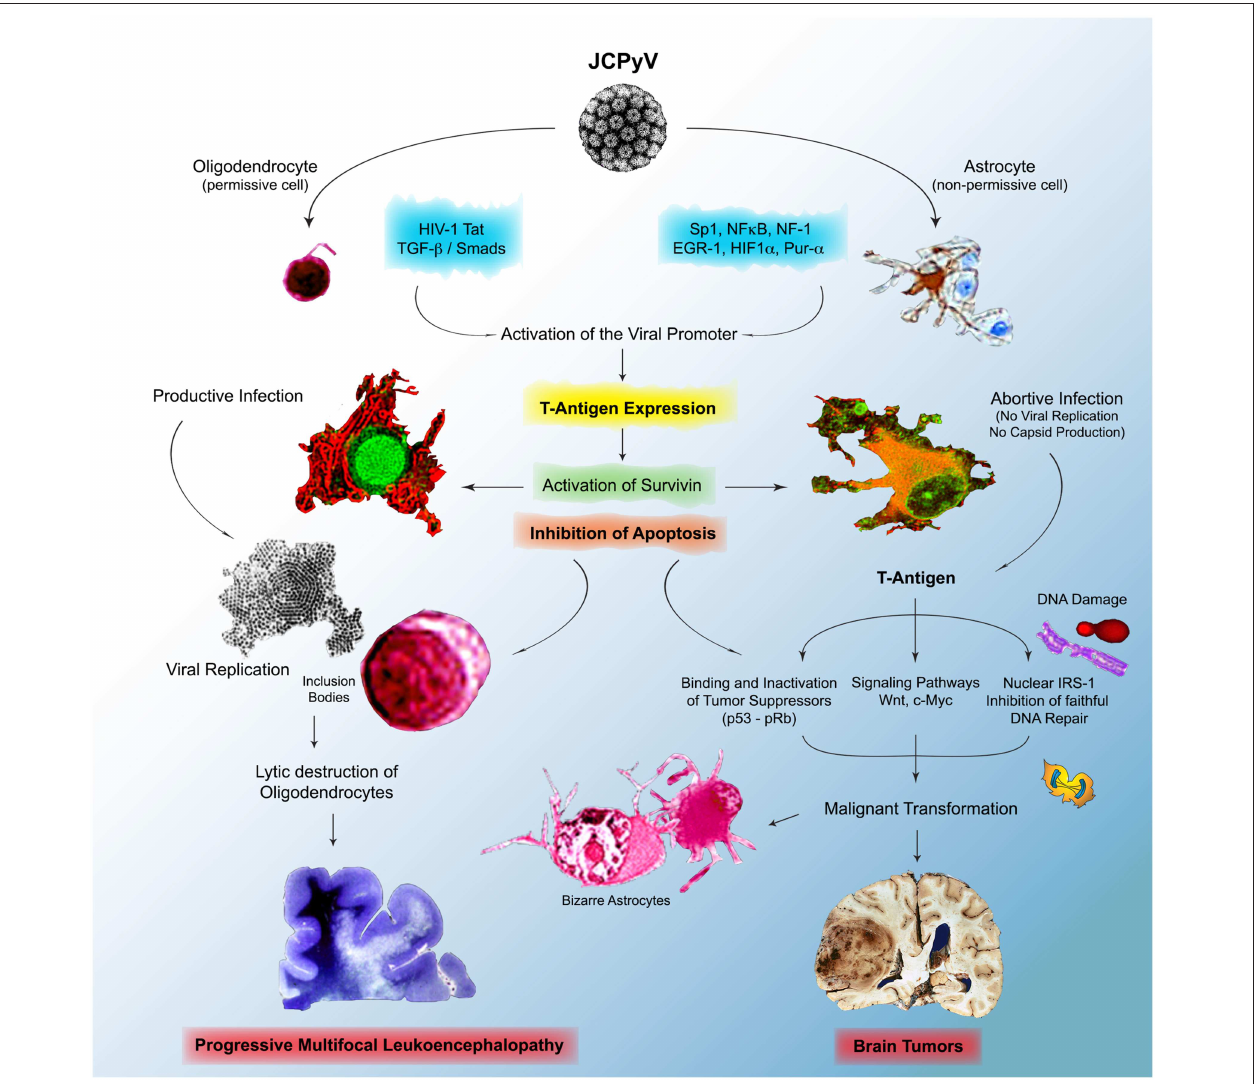
FIGURE 6 | Physiopathology of JCPyV in the brain. JCPyV enter the brain and infects both phenotypes of glial cells, oligodendrocytes and astrocytes, which results in the activation of the normally dormant protein Survivin, which results in the inhibition of apoptosis, a mechanism to dispose of virally infected cells. In oligodendrocytes, permissive to active infection, this allows time for JCPyV to complete its life cycle, which results in active viral replication in the nuclei, the formation of inclusion bodies, and the lytic destruction of the myelin producing cells end in Progressive Multifocal Leukoencephalopathy. In astrocytes, where the infection is abortive, no viral replication takes, but the viral oncoprotein T-Antigen is expressed. T-Antigen binds and inactivates p53 and pRb, crucial tumor suppressors and can affect important cell cycle regulator pathways, including the Wnt signaling pathway, resulting in the activation of c-Myc. Infection with JCPyV also causes DNA damage, and by binding to IRS-1, the downstream protein if the IGF-1 pathway, it inhibits faithful DNA repair, forcing cells to repair their DNA via non-homologous end-joining, which results in mutations. All these are contributing factors of cellular transformation, which in certain individuals may results in the development of brain tumors.